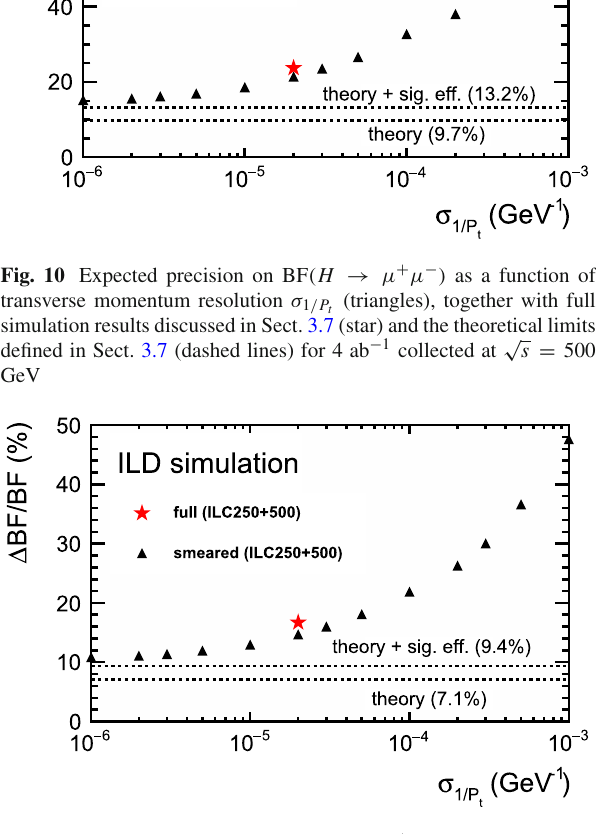
Fig. 11 Expected precision on BF ( H → μ + μ − ) as a function of transverse momentum resolution σ 1 / P (triangles), together with full t simulation results discussed in Sect. 3.7 (star) and the theoretical limits defined in Sect. 3.7 (dashed lines) for the combination of the 2 ab − 1 √ √ s = 250 GeV and 4 ab − 1 collected at s = 500 collected at